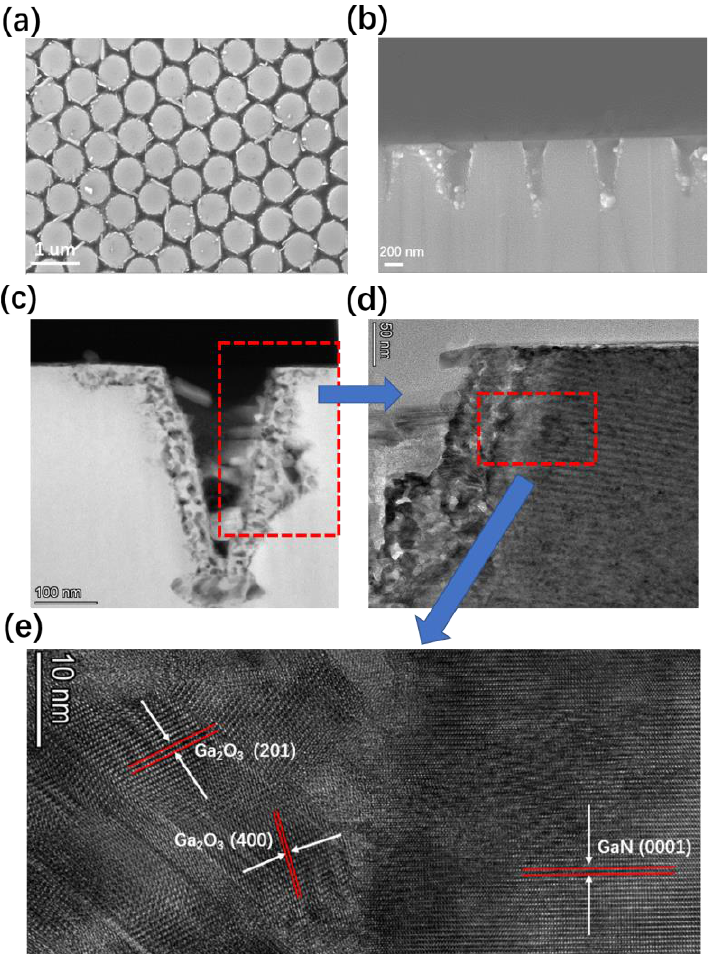
Figure 6. ( a ) Surface morphology of the oxidized Ga 2 O 3 /GaN NRAs. ( b ) Cross-section SEM image of Ga 2 O 3 /GaN NRAs. ( c , d ) Low-magnification TEM image of the core-shell NRA. ( e ) HR-TEM image of the core-shell NRA.